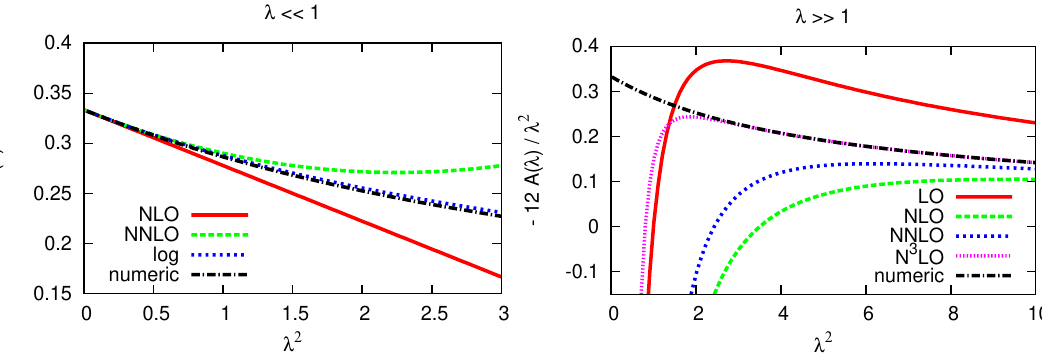
Figure 2 . Comparison of (cid:0) 12 A ( (cid:21) ) =(cid:21) 2 with the two asymptotic regimes. Left: small (cid:21) expan- sion (4.5) with log referring to the right most side of (4.5). Right: the large (cid:21) expansion